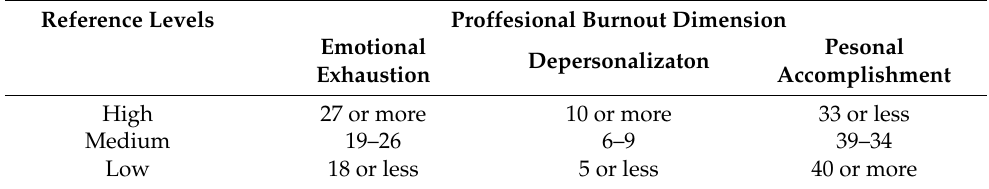
Table 1. Reference levels of professional burnout according to MBI for health care